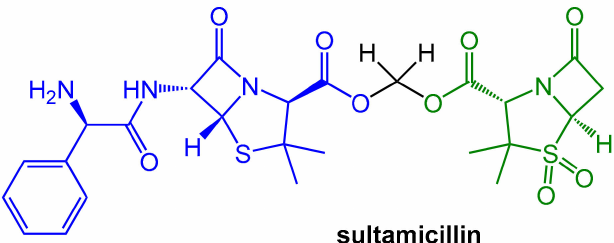
Figure 4. In the “mutual prodrug” sultamicillin, the β -lactamase-labile antibiotic ampicillin (blue) and the β -lactamase inhibitor sulbactam (green) are connected with an esterase-labile di-ester moiety. Enzymatic ester hydrolysis releases both active compounds as well as one equivalent